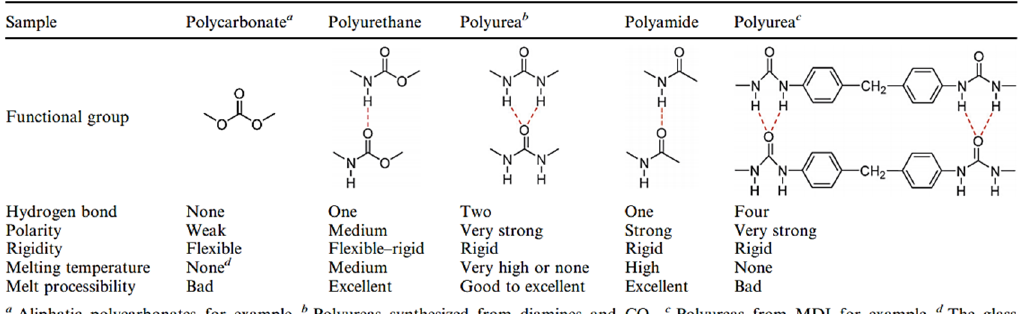
Figure 49. Comparison of some polymers with similar functional groups. From reference [1].